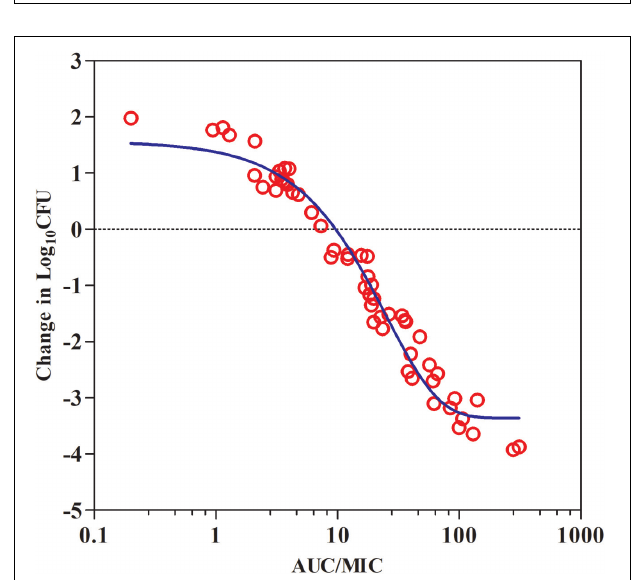
FIGURE 3 | PAE and PA-SME values (h) of tulathromycin against S. suis ATCC 43765. The PA-SMEs were determined after initial exposure to tulathromycin at 4 × MIC. The error bars represent SD ( n = 3).